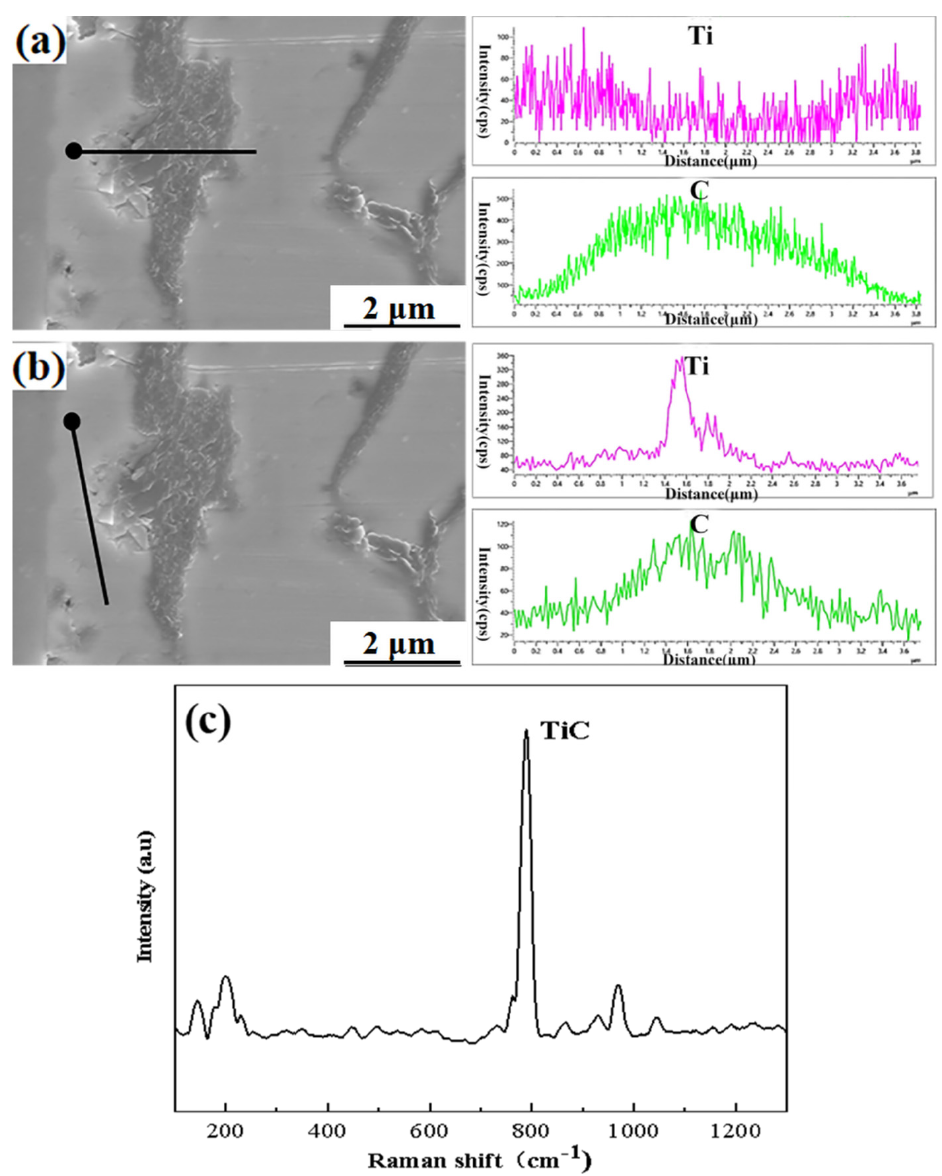
Figure 5. Graphite line scan path and analysis near the Ht250/Ti/Cu joint: ( a ) Line scan path through graphite; ( b ) line scan path tangential to graphite; ( c ) the TiC Raman spectrum analysis.